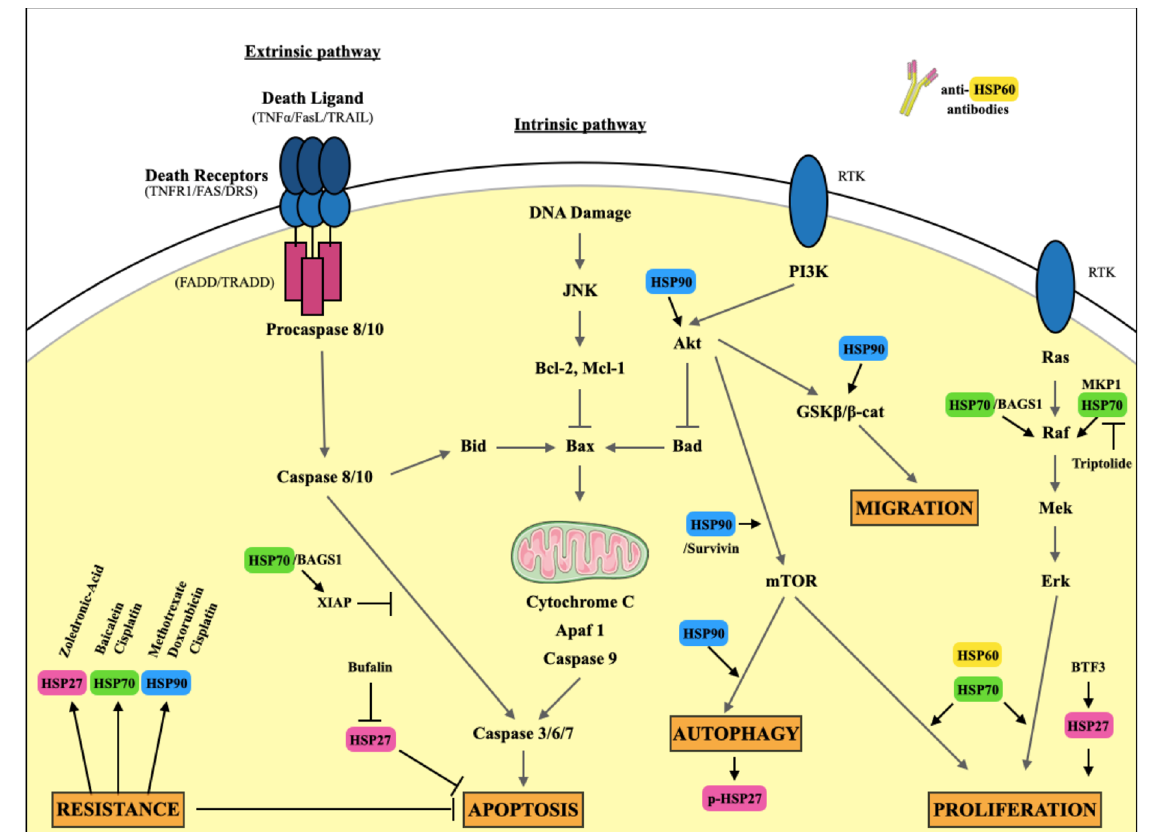
Figure 3. Overview of the major signaling pathways involving HSPs in cancer promotion in OS. HSP27, HSP60, HSP70 and HSP90 are involved in different ways in OS cell proliferation, apoptosis, migration, autophagy and resistance. BAG: Bcl-2 associated athanogene; XIAP: X-linked inhibitor of apoptosis protein; Apaf: Apoptotic peptidase factor; Bid: BH3 interacting-domain death agonist; Bax: Bcl-2 associated X protein; Bad: Bcl-2 associated death promoter; JNK: c-Jun N-terminal kinases; Bcl: B-cell lymphoma; Mcl: Induced myeloid leukemia cell differentiation protein; Akt: Protein kinase B; PI3k: Phosphoinositide 3-kinase; RTK: Receptor tyrosine kinase; GSK: Glycogen synthase kinase; MKP: MAPK phosphatases; Raf: Rapid accelerated fibrosarcoma; Mek: Mitogen-activated protein kinase kinase; Erk: Extracellular signal regulated kinases; TNF: Tumor necrosis factor; TRAIL: Tumor necrosis factor related apoptosis inducing ligand; FADD: Fas associated protein with death domain; TRADD: Tumor necrosis factor receptor type 1-associated death domain protein.